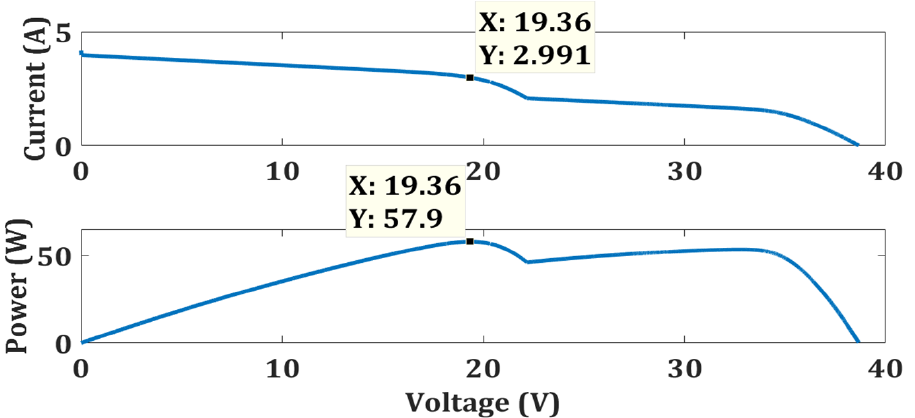
Figure 20. Characteristic curves of 3S PV system for test case 2 .